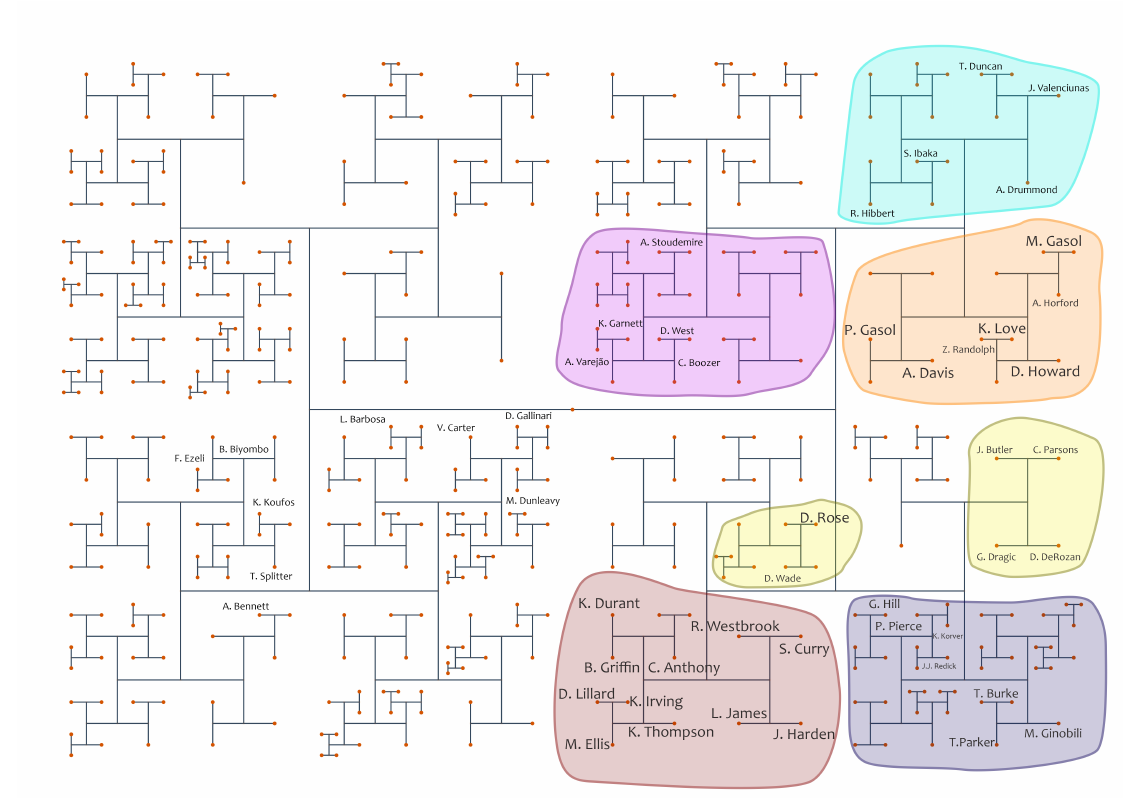
Figure 13. Backbone of the #NBABallot dataset. A few vertices are labeled to highlight some players. Colored groups display leading players that share characteristics and